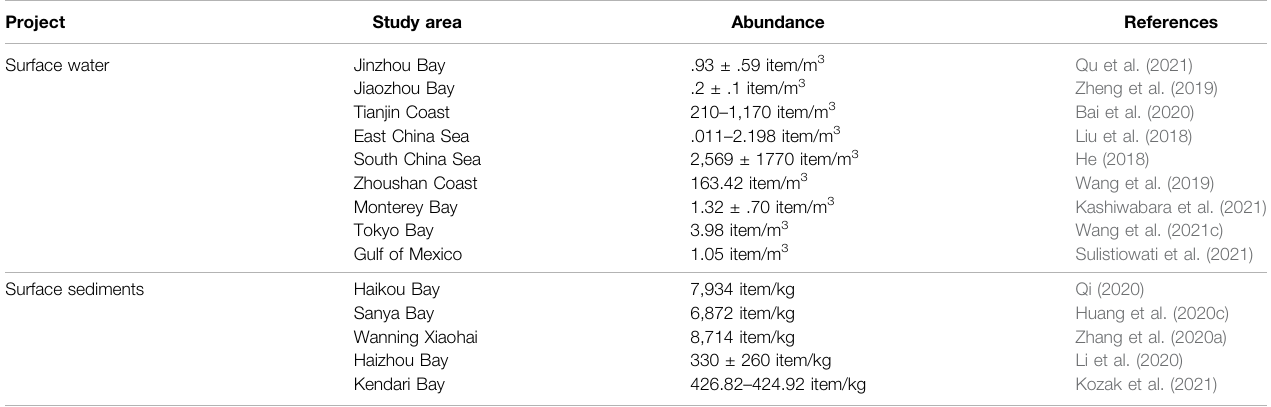
TABLE 2 | Microplastic abundances observed in the bays around the